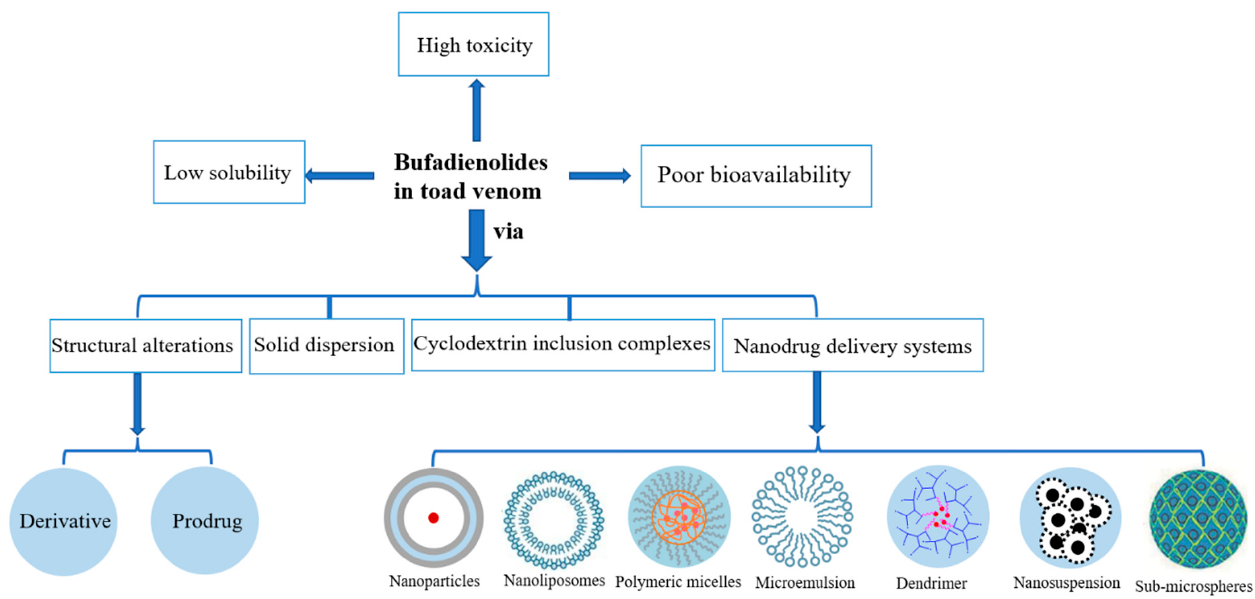
Figure 4. Strategies to improve solubility and bioavailability of bufadienolides.